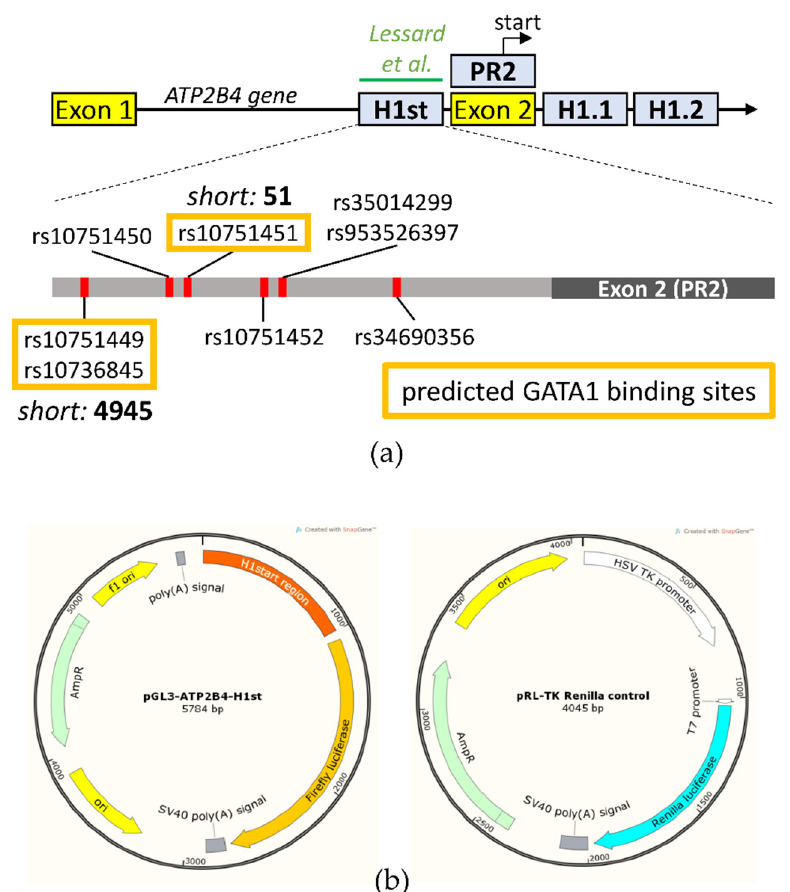
Figure 1. ( a ) Schematic presentation of haplotype location in the ATP2B4 gene, previously indicated to be responsible for the regulation of PMCA4b expression. Yellow boxes label the first and the second exon—the promiscuous promoter is located around exon 1, while the recently identified enhancer/second promoter is located around exon 2, where the haplotype can be found. Blue boxes indicate the constructs used in this study. In the H1-start (H1st) region, corresponding to the erythroid-specific regulatory region described by Lessard et al. [10] (green), the SNPs of the minor haplotype are also depicted. SNPs predicted to eliminate GATA1 binding sites are labeled by yellow boxes. ( b ) Maps of plasmids used in the dual-luciferase expression assays (created by SnapGene).